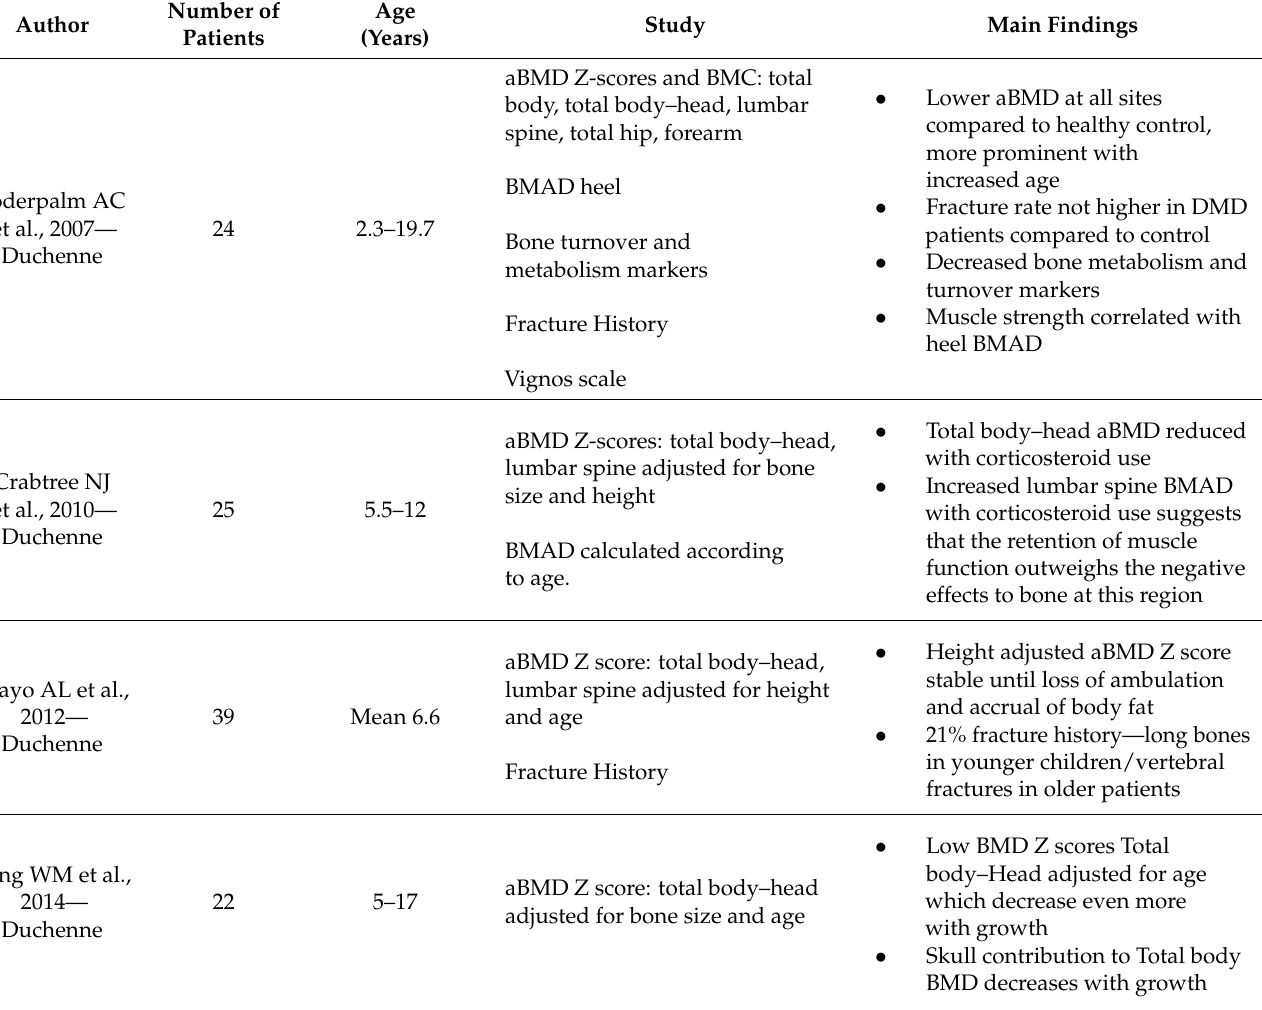
Table 1. Studies evaluating bone quality in patients with Duchenne Muscular